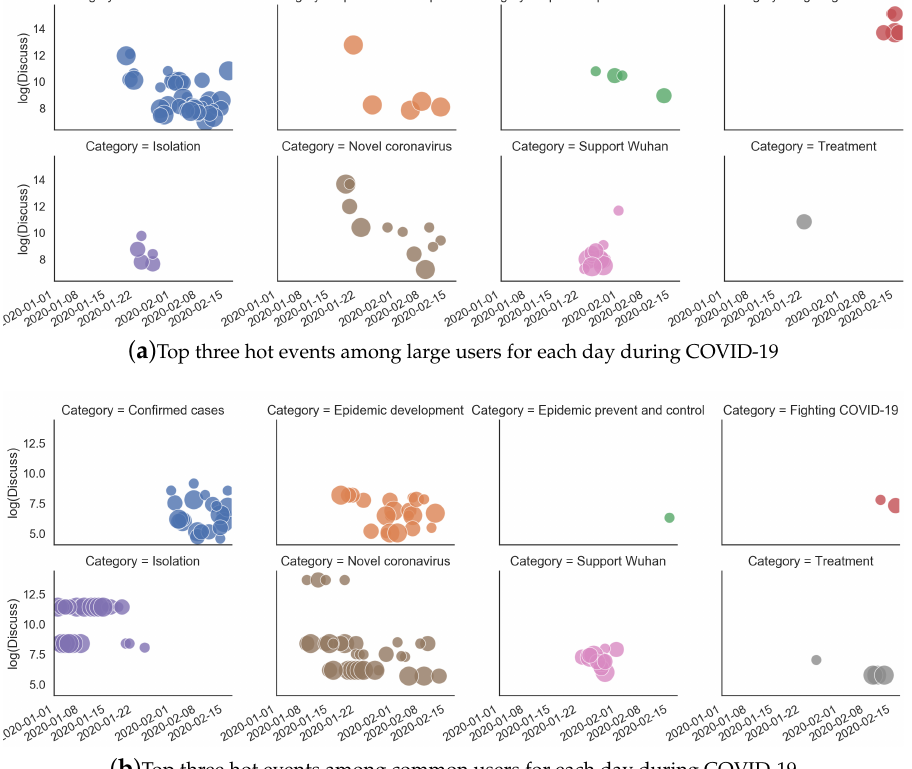
Figure 4. Hot events during COVID-19 extracted from microblog super topics from 1 January